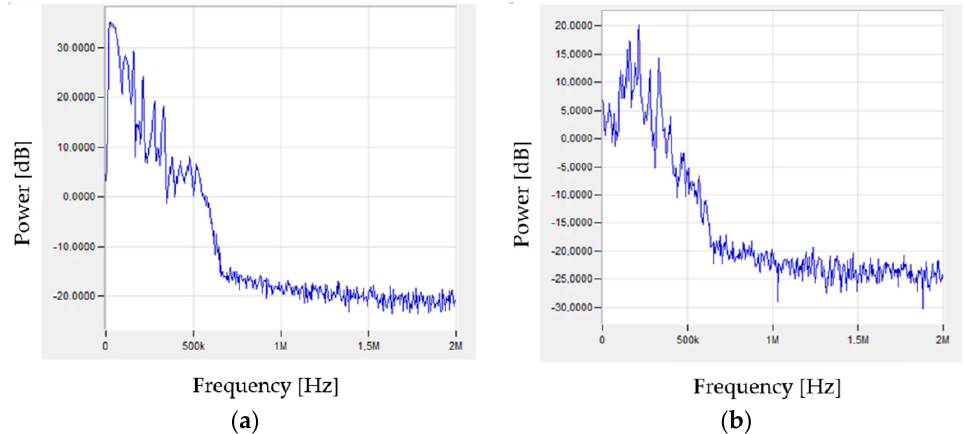
Figure 9. Examples of signals, after FFT analysis, characteristic for cracking of matrix: ( a ) sample of pure resin, ( b ) composite.